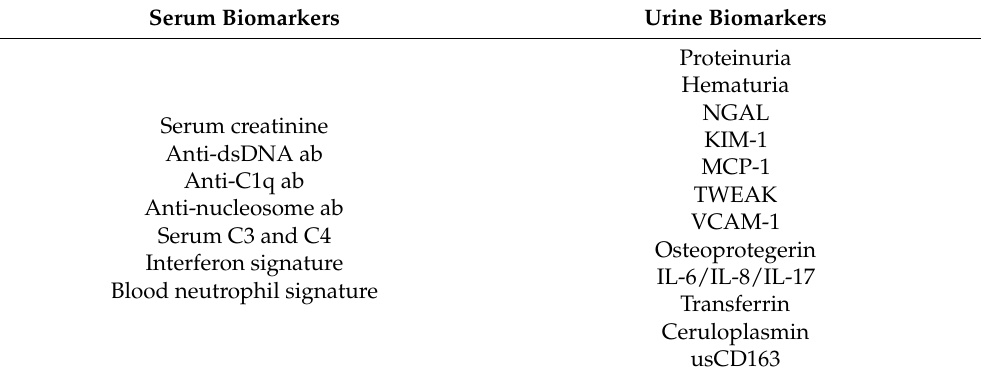
Table 6. Traditional and potential biomarkers reflecting LN activity (adapted after [10,82,85]. Serum Biomarkers Urine Biomarkers